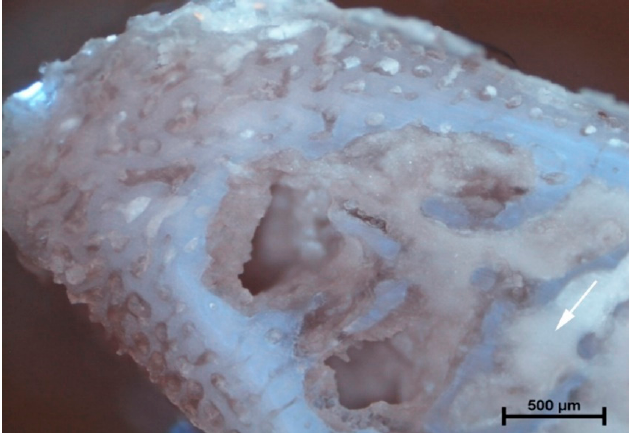
Figure 2. Rotation of 800 rpm (3 °C). The apical area of rib filled with connective tissue. Visible area of tissue compression caused by the drill (arrow).